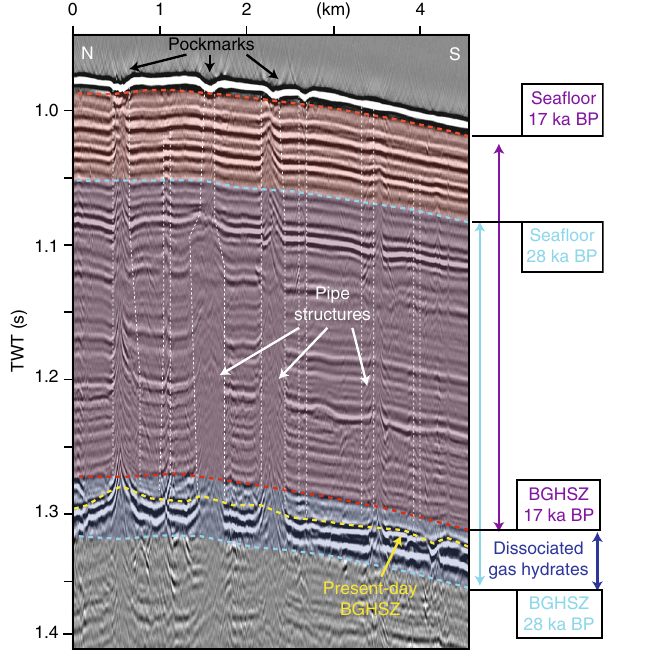
Fig. 2 Pockmarks and pipe structures at Nyegga. Seismic pro fi le with pipe structures, pockmarks, the present-day base of the gas hydrate stability zone (yellow) and calculated bases of the gas hydrate stability zone at 17 ka BP (blue) and 28 ka BP (red)